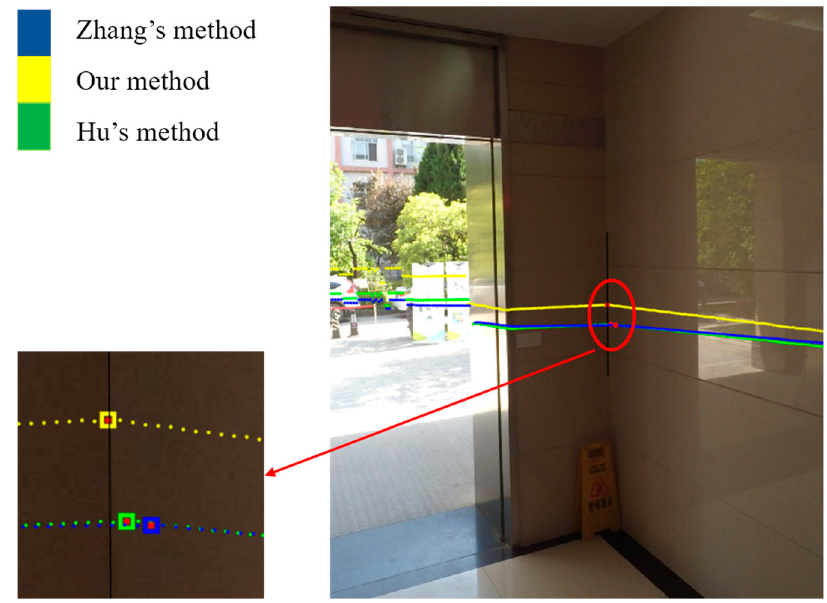
Figure 16. Projection of LRF range data on the image (indoor).